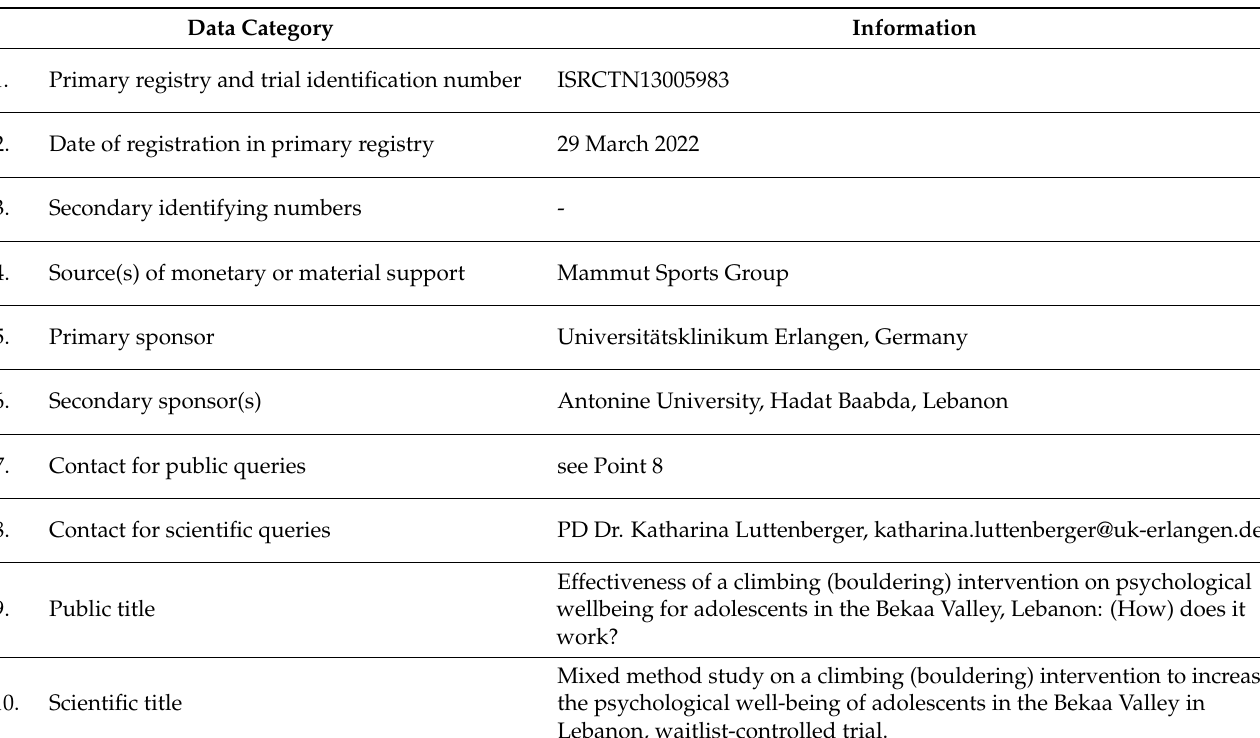
Figure 1. SPIRIT Participant timeline. Table 1. Trial Registration Data according to SPIRIT guideline.